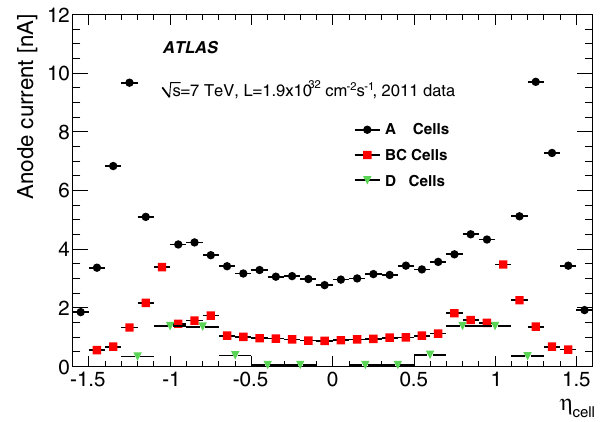
Fig. 17 The PMT current as measured by the slow integrator read-out as a function of cell η and averaged over all modules for the three layers in the LB and EB, using minimum-bias data collected in 2011 at a fixed instantaneous luminosity (1 . 9 × 10 32 cm − 2 s − 1